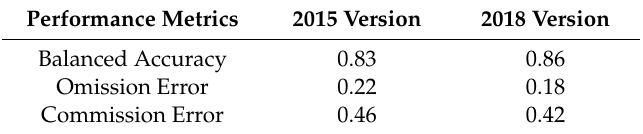
Table 7. Performance metrics of built-up land data based on pixel accuracy evaluation